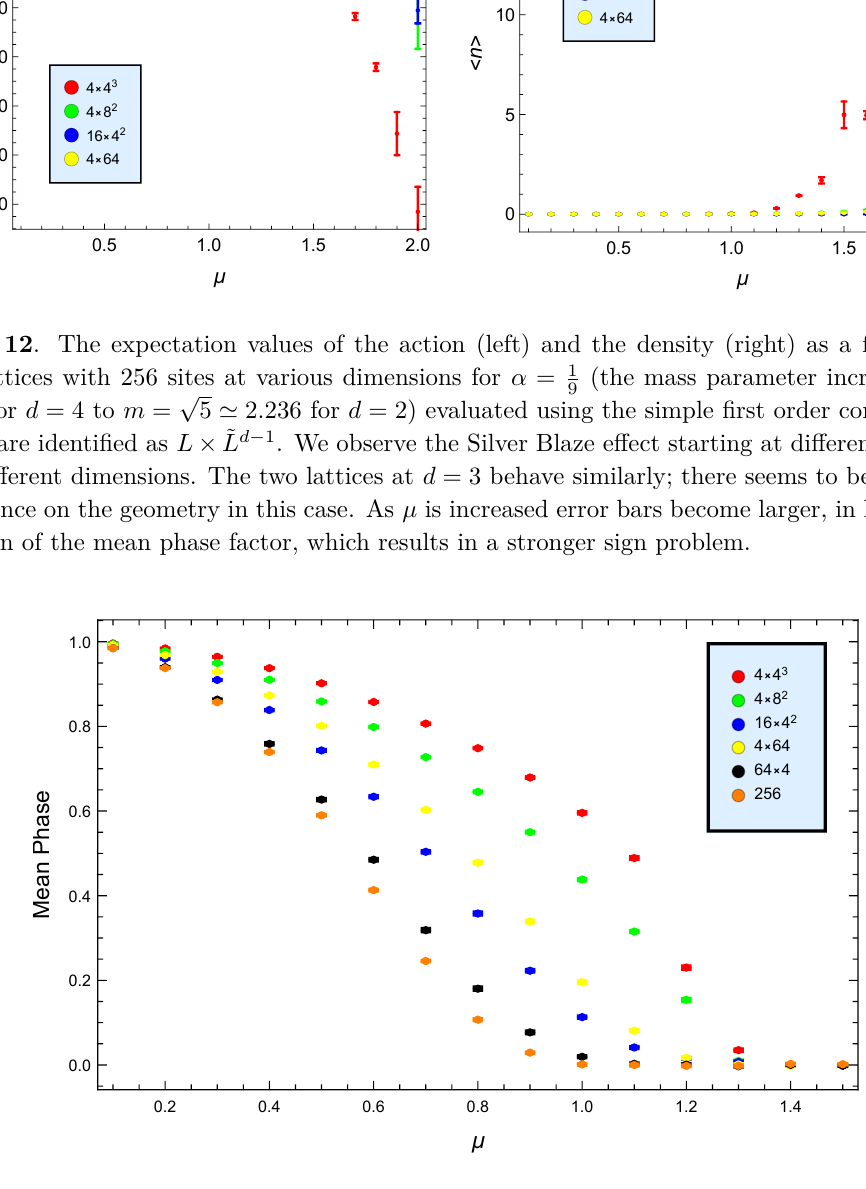
Figure 13 . The mean phase factor as a function of µ for lattices with 256 sites at various dimensions for m = 1 ( α decreases from α = 1 for d = 1 to α = 1 for d = 4 ) evaluated using the simple first 3 9 order contour. The lattices are identified as L × ˜ L d − 1 . The expected behaviour of higher mean phase factor for larger d is indeed observed. This can be masked by geometry factors. Indeed, the phase factors of the 4 × 64 lattice are larger than those of the 16 × 4 2 one. On the other hand it seems that the effect of the increase of the size of the boundary, where additional contributions to Im( S ) are present, is not very significant, at least in the current